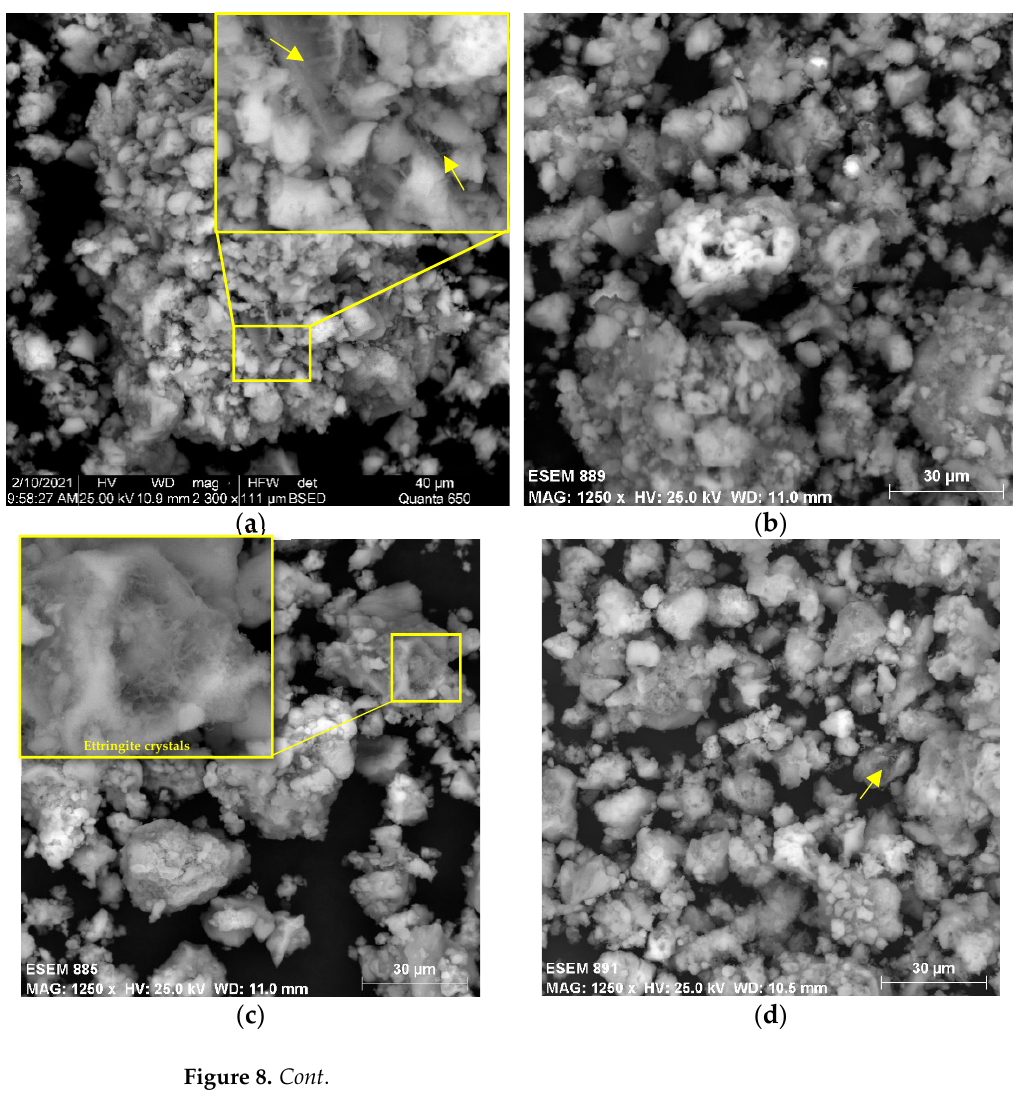
Figure 7. XRD spectra of CF1, CF2, and CF3 before and after the 1315 test.